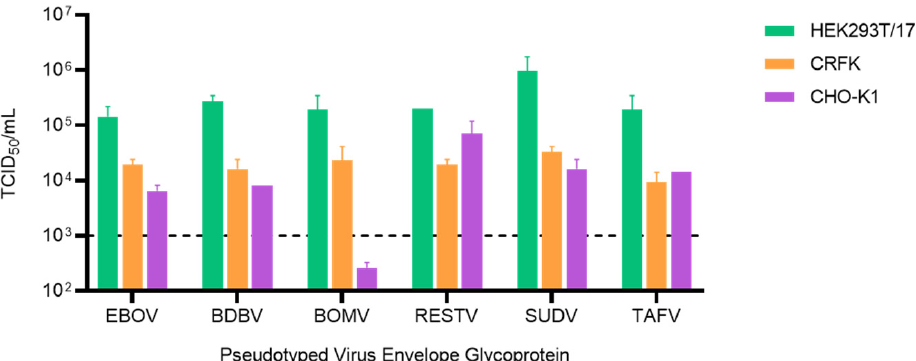
Figure 2. Comparison of ebolavirus-pseudotyped virus infectivity on different target cell lines. Titres calculated as TCID 50 /mL for pseudotyped virus incorporating ebolavirus envelope glycoproteins titrated on HEK293T/17, CRFK and CHO-K1 target cells. The dotted line indicates the minimum titre required for downstream neutralisation